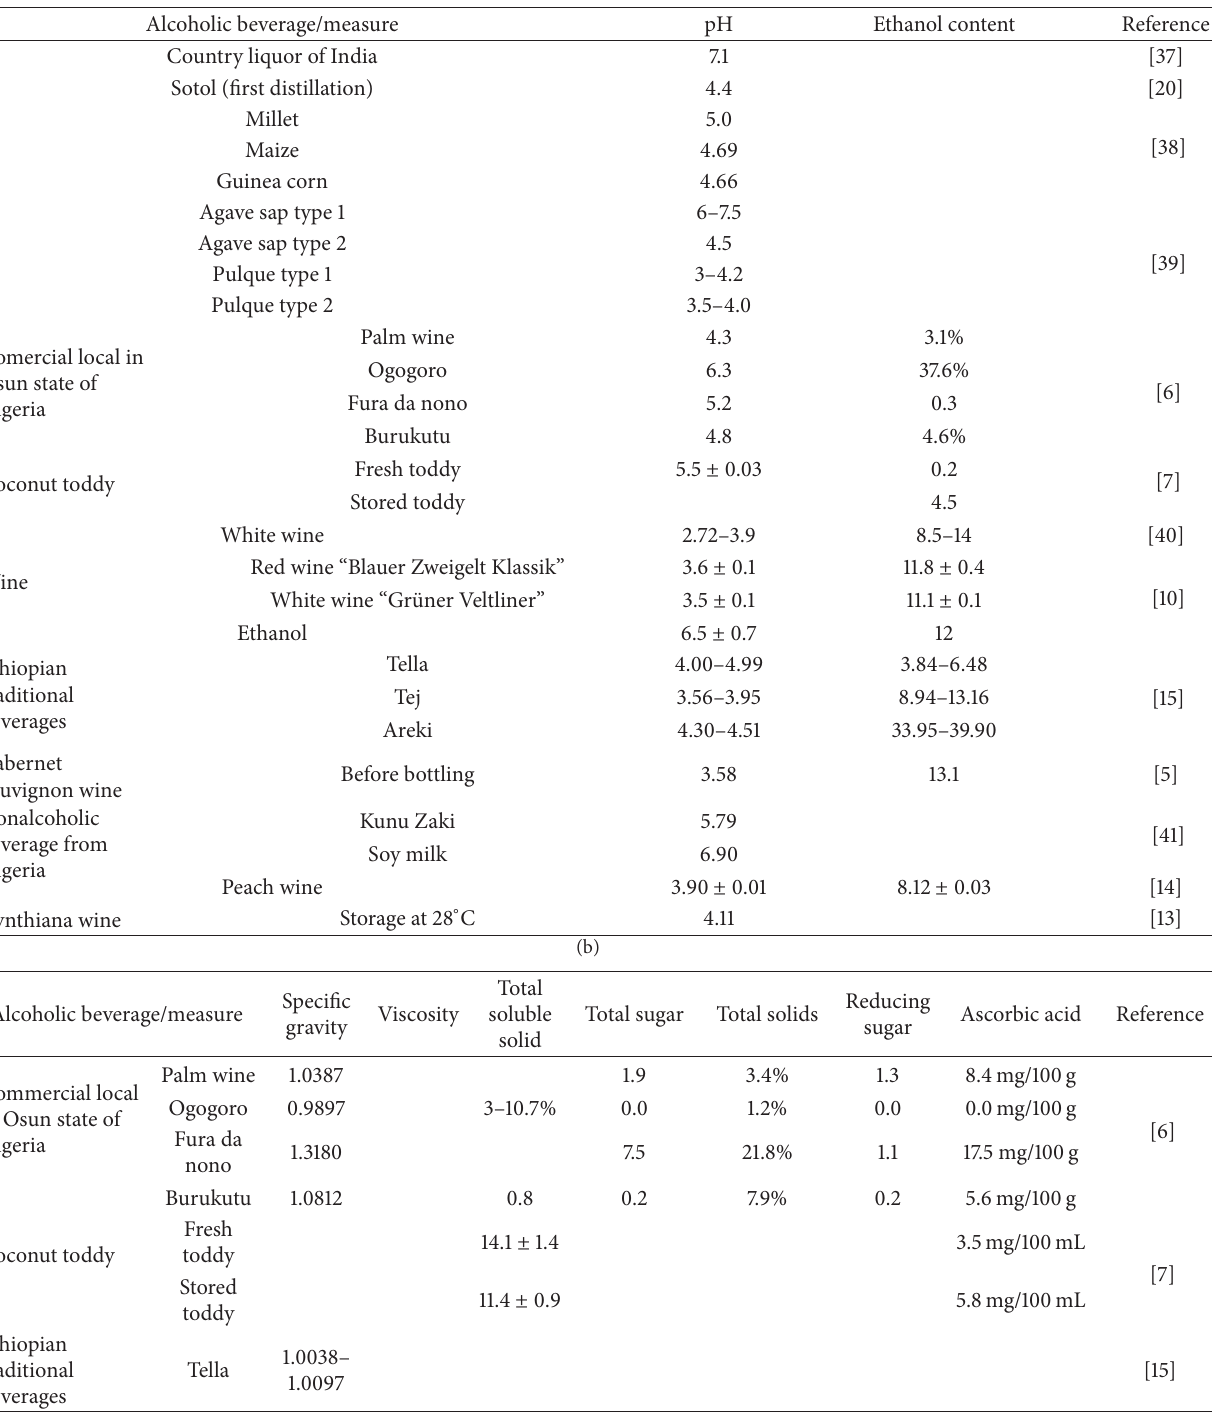
Table 4: Summary of the physicochemical properties of different traditional, spirituous beverages worldwide. (a) pH and ethanol content, (b) specific gravity, viscosity, total soluble solid, total sugar, total solids, reducing sugar, and ascorbic acid, (c) refractive index, titratable acidity, density, conductivity, and alcohol